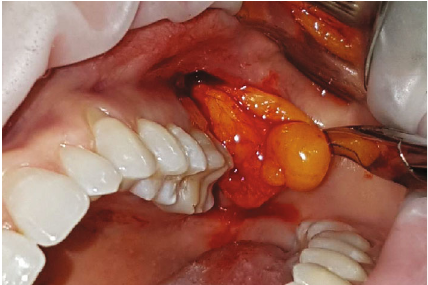
Figure 5: Removal of the buccal extension of the Bichat ball.